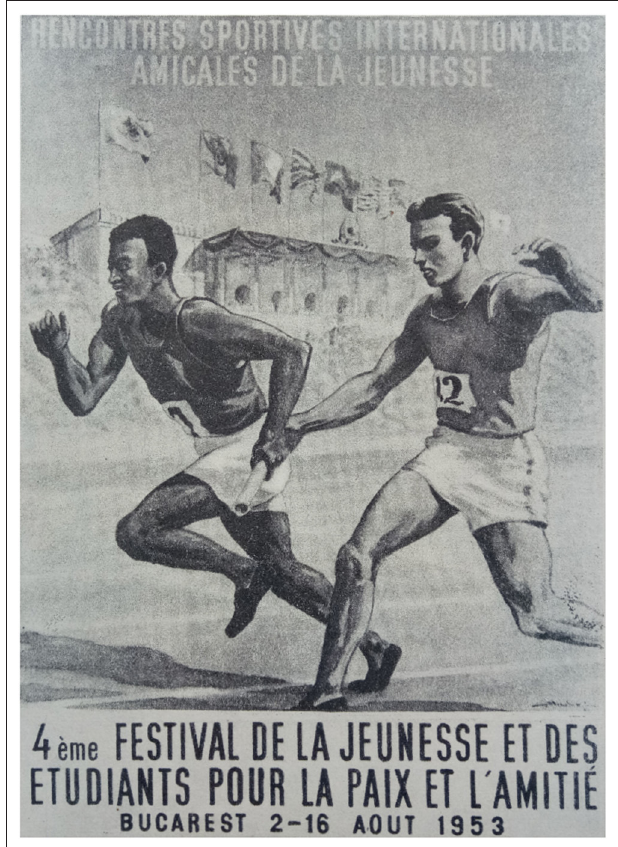
FIGURE 1 | Billboard of the International Friendly Youth Sports Meetings, Bucharest, 1953. Source: Newspaper of the International Preparatory Committee, April 28–May 4, 1953,